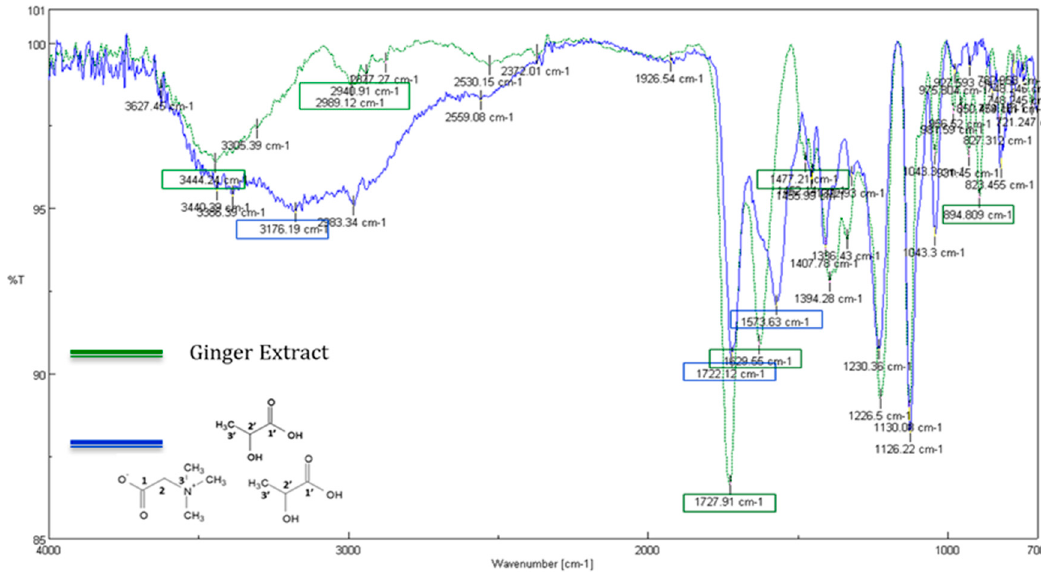
Figure 6. FTIR (ATR) spectra of NaDES Bet/LA (blue) and ginger extract